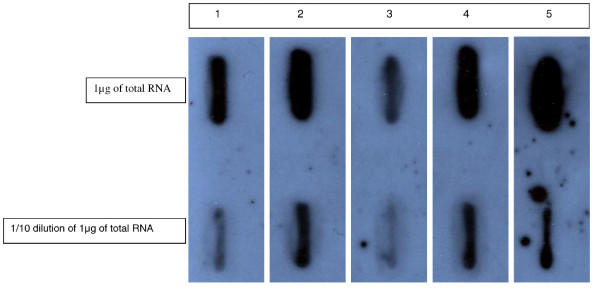
RNA dot blot. RNA samples were taken from bacteria pre-incubated overnight in fRPMI and incubated together with catheter fragments in fRPMI-Fe25. In the first row, each blot contains 1 μg of total RNA, in the second row each blot contains a 1/10 dilution of 1 μg of total RNA. The probe used for the hybridization is the sitC-specific RNA probe. Lane 1: RNA from planktonic bacteria after overnight incubation in fRPMI; Lane 2: RNA from sessile bacteria grown in fRPMI-Fe25; t = 2 hrs; Lane 3: RNA from planktonic bacteria grown in fRPMI-Fe25; t = 2 hrs; Lane 4: RNA from sessile bacteria grown in fRPMI-Fe25; t = 6 hrs; Lane 5: RNA from planktonic bacteria grown in fRPMI-Fe25; t = 6 hrs;